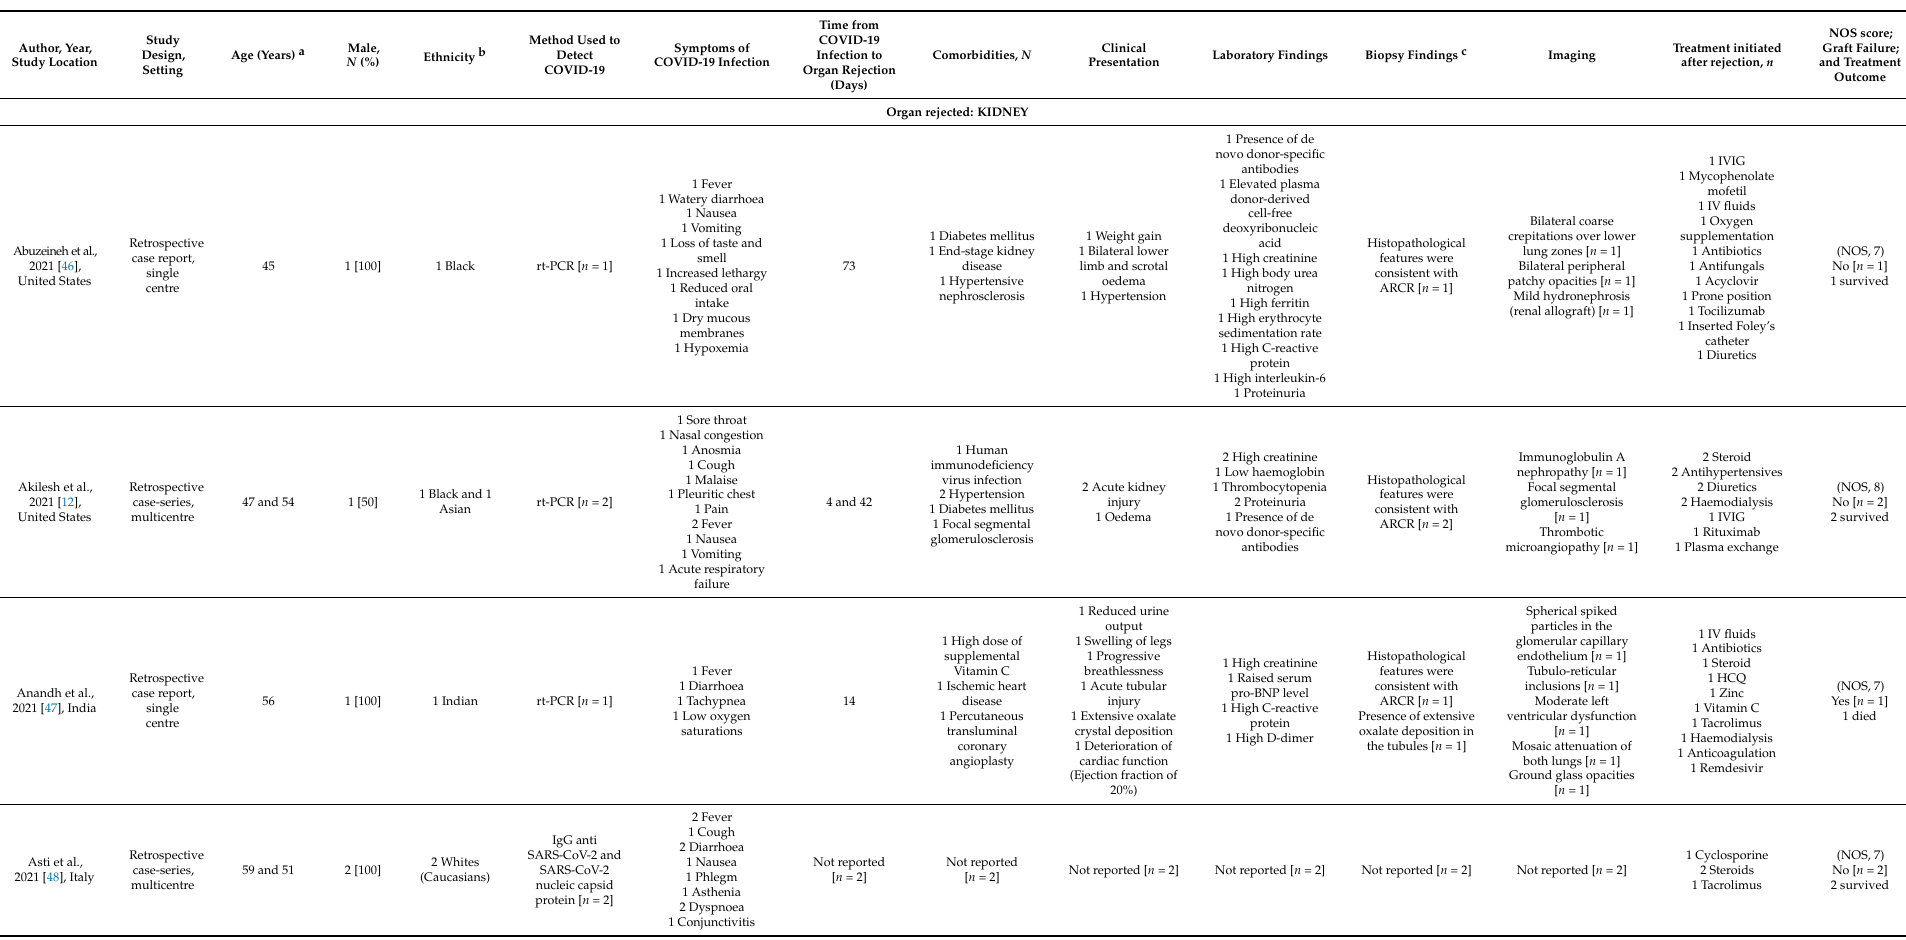
Table 2. Summary of the characteristics of the included studies with evidence on organ rejection post-COVID-19 infection ( n = 20 studies),